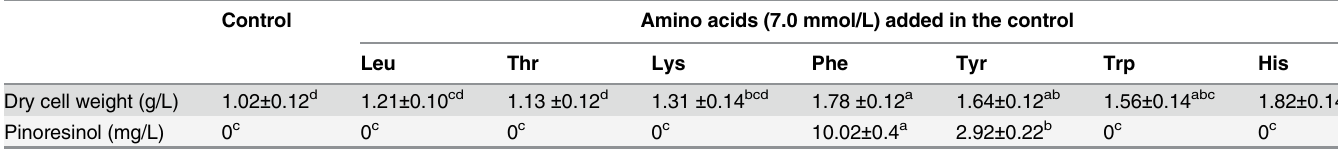
Table 2. Production of Pin by Phomopsis sp. XP-8 cells using different amino acids in the absence of glucose. Values are the means of three replica- tions and shown with standard